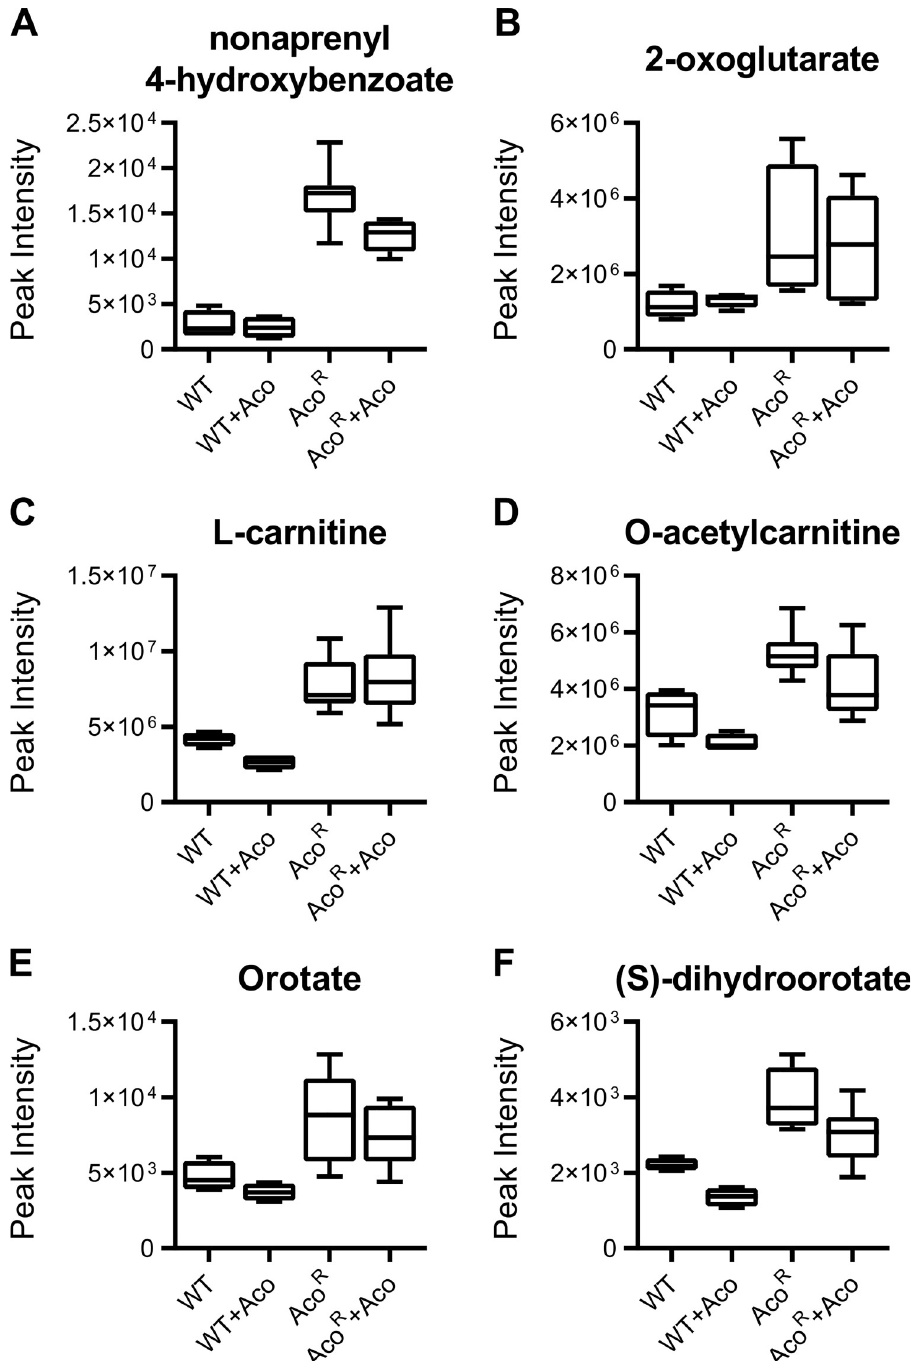
Fig 4. Metabolites elevated significantly in Aco R cells. Metabolomics data was mined to identify metabolites altered in Aco R cells compared to wild-type T . brucei . Metabolites identified as nonaprenyl 4-hydroxybenzoate (A) and 2-oxoglutarate (B) support the indications that the Aco R is in a differentiated state, as they are involved with ubiquinone and citric acid cycle metabolism, respectively. Levels of both L-carnitine (C) and O-acetylcarnitine (D) are reduced in wild-type cells after acoziborole-treatment. However, both were observed at significantly higher levels in Aco R cells both in the presence and absence of acoziborole. Orotate (E) and (S)-dihydroorotate (F) are intermediates of uridine monophosphate and ultimately, uridine triphosphate biosynthesis, which is required for UTP-dependent mitochondrial mRNA polyadenylation. Levels of these metabolites are similarly reduced in acoziborole-treated wild- type cells, but elevated in Aco R cells. Abbreviations: Aco, acoziborole.